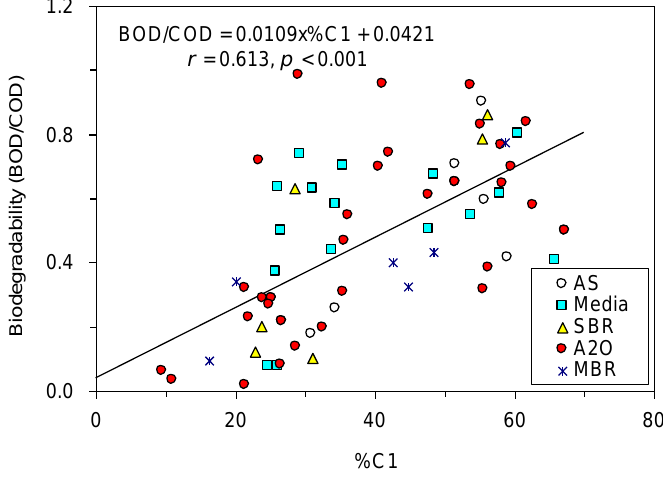
Figure 5. Relationship between the biodegradability of TOC (BOD/COD) and the fraction of protein-like C1 in total fluorescence